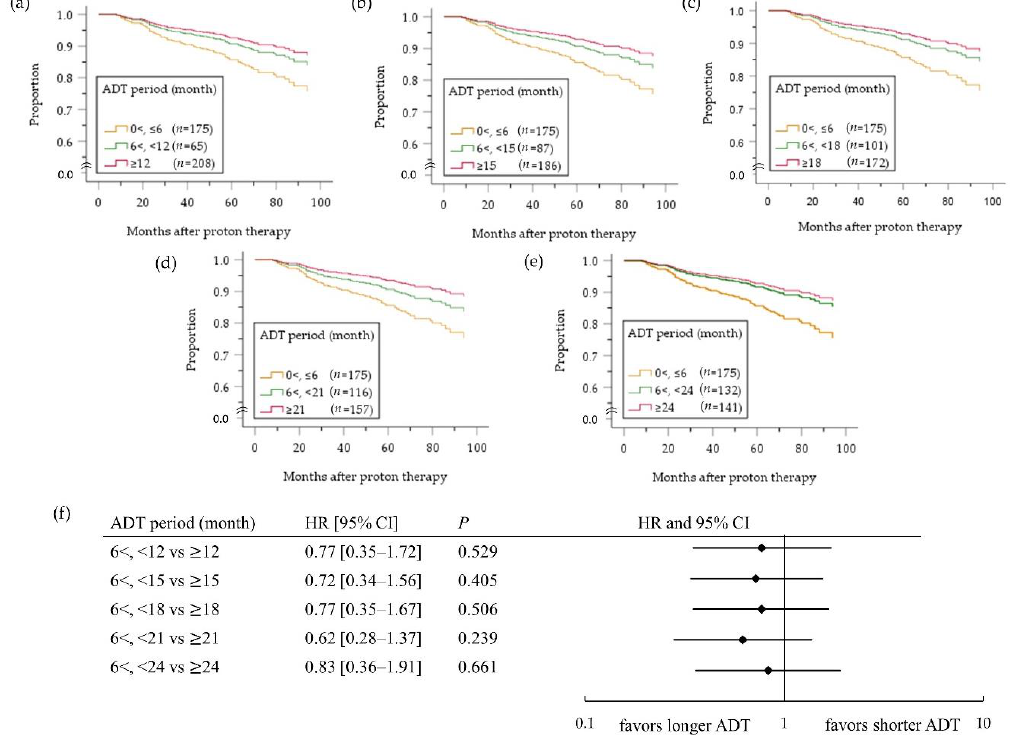
Figure 5. Cumulative survival function ( a – e ) and forest plots ( f ) assessing the risk of biochemical relapse in high-risk PC patients with ADT according to the ADT duration (months): <X vs. ≥X months (a: X = 12; b: X = 15; c: X = 18; d: X = 21; e: X = 24 months). ADT, androgen deprivation therapy; HR, hazard ratio; CI, confidence interval.